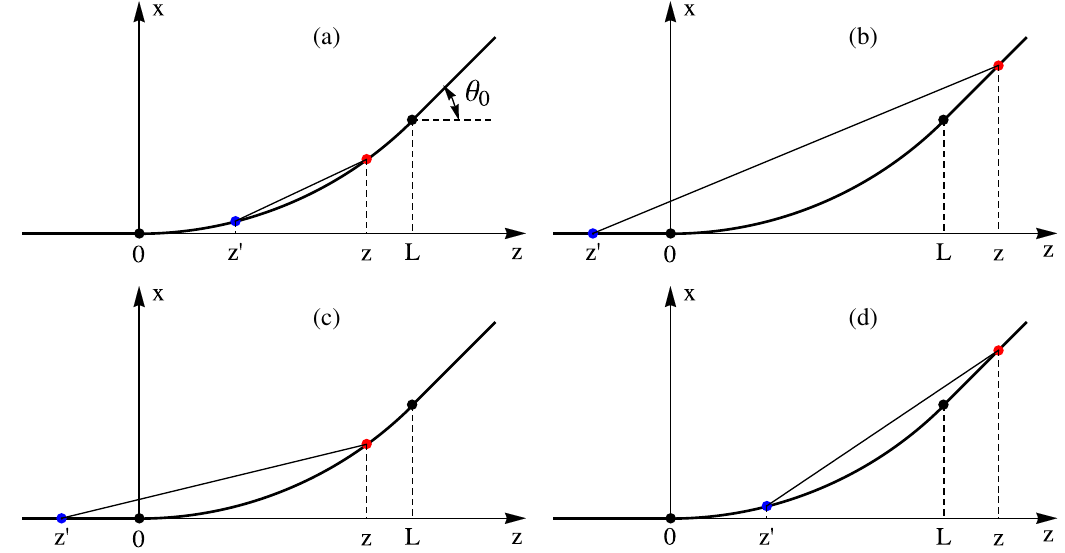
FIG. 6. The orbit for a bending magnet of length L consists of a straight line z < 0 , a circular arc occupying the region 0 < z < L and a straight line in the region z > L tilted at angle θ 0 . Panels (a), (b), (c), and (d) show four different situations for relative locations of the leading point z (shown by the red dot) and that of the trailing point z 0 (shown by the blue dot). The beam moves from left to right.